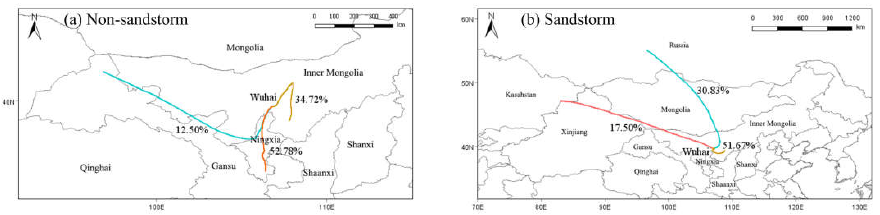
Figure 5. Analytical results of 72 h backward trajectories cluster of air mass in Wuhai during non- sandstorm ( a ) and sandstorm ( b ) intervals.